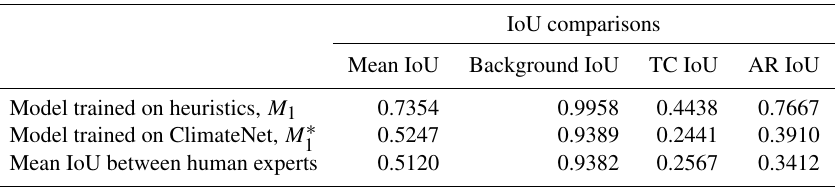
Table 2. Model M 1 achieves IoU scores similar to those reported in Kurth et al. (2018). After training on ClimateNet, model M ∗ similar to human experts. The overall mean IoU is limited by the TC